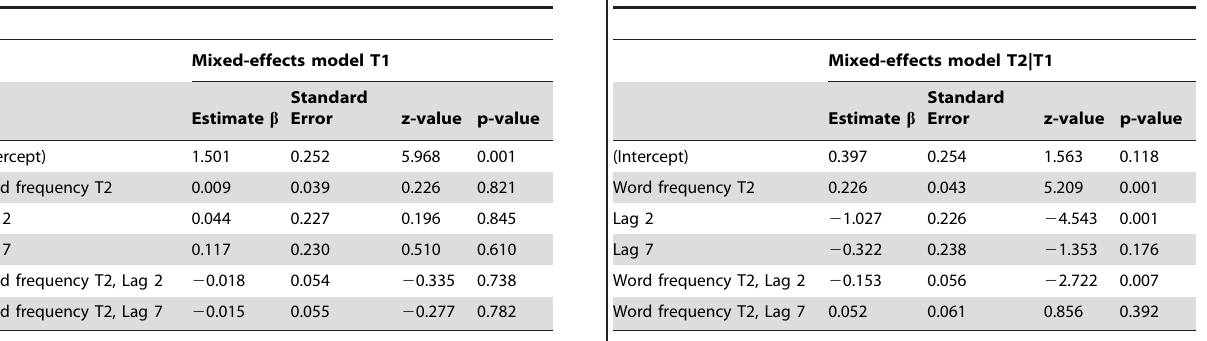
Table 4. The estimates and z-values of the mixed-effects model for T2|T1 accuracy.